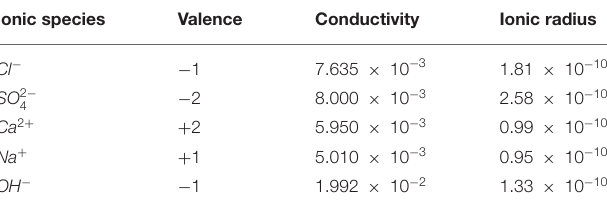
TABLE 2 | Parameter value of ions in pore solution (Chatterji and Kawamura, 1992). Ionic species